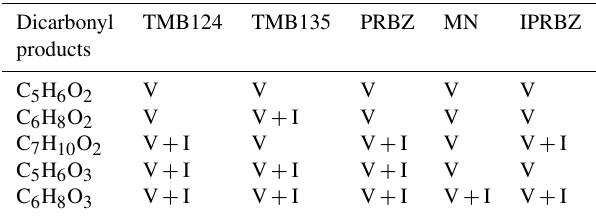
Table 2. Dicarbonyl products observed in the gas and particle phase from Arey (2009) under low-NO x conditions (V – Vocus; I – I- CIMS). Note: PRBZ – PROPBENZ; MN – METHNAP; IPRBZ – IPRBENZ. Dicarbonyl TMB124 TMB135 PRBZ MN IPRBZ products C 5 H 6 O